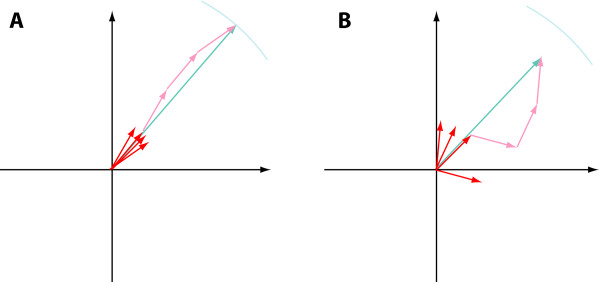
Principle of determining the consistency of the observed behavior pattern. The gene in panel (A)  shows highly consistent regulation among the various pairwise comparisons of replicates. Hence the corresponding unit vectors add to a long sum vector. The gene in panel (B)  is noisier and slightly inconsistent in its response pattern among replicates. Its vectors add to a shorter sum vector.